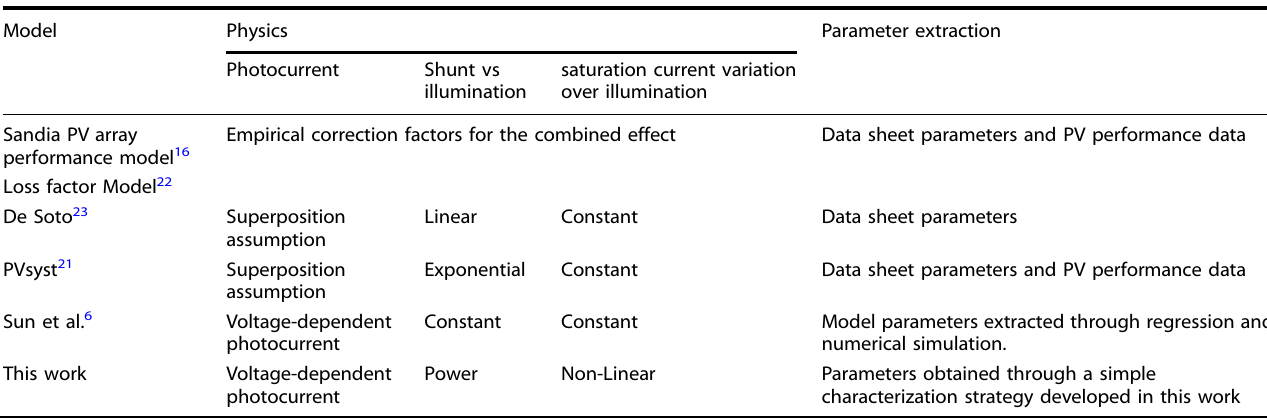
Fig. 2 Power – Voltage ( P – V ) characteristics estimated by the De Soto 23 and PVsyst models 21 for a 150 Wp CIGS module compared with the measured IV curves. a Comparison for different irradiance intensities at 25 °C. b Comparison of IV curves for different module temperatures at 1000 W m − 2 . The markers represent the measured curves while the dotted lines show the IV curve estimation of the De Soto (green) and PVsyst models (magenta). The brown arrows indicate the order in which the PV curves are arranged (35 °C, 55 °C, 65 Table 1. Comparison of the state-of-the-art models for CIGS PV technology with the model proposed in this work.